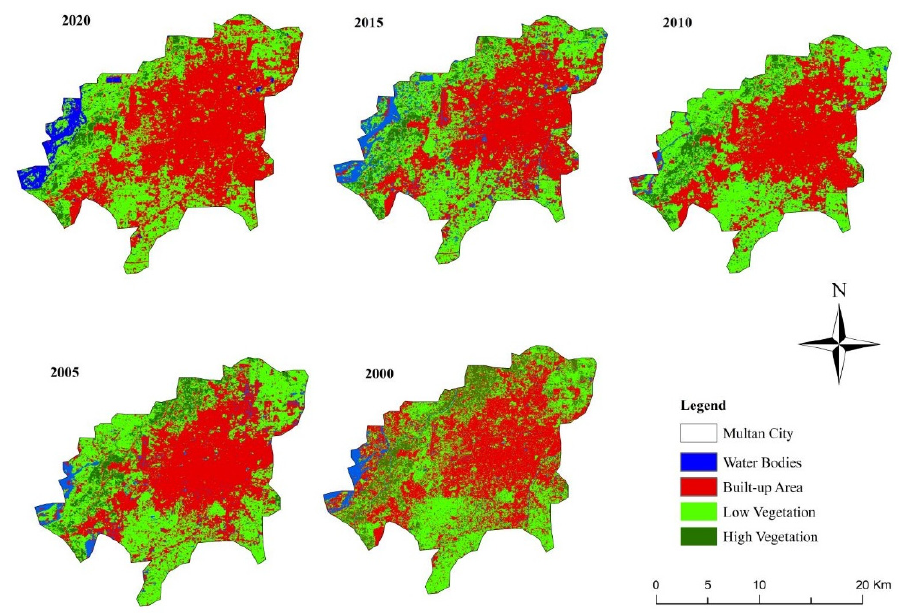
Figure 10. Land ‐ use land cover changes from 2000 to 2020 of the study area.